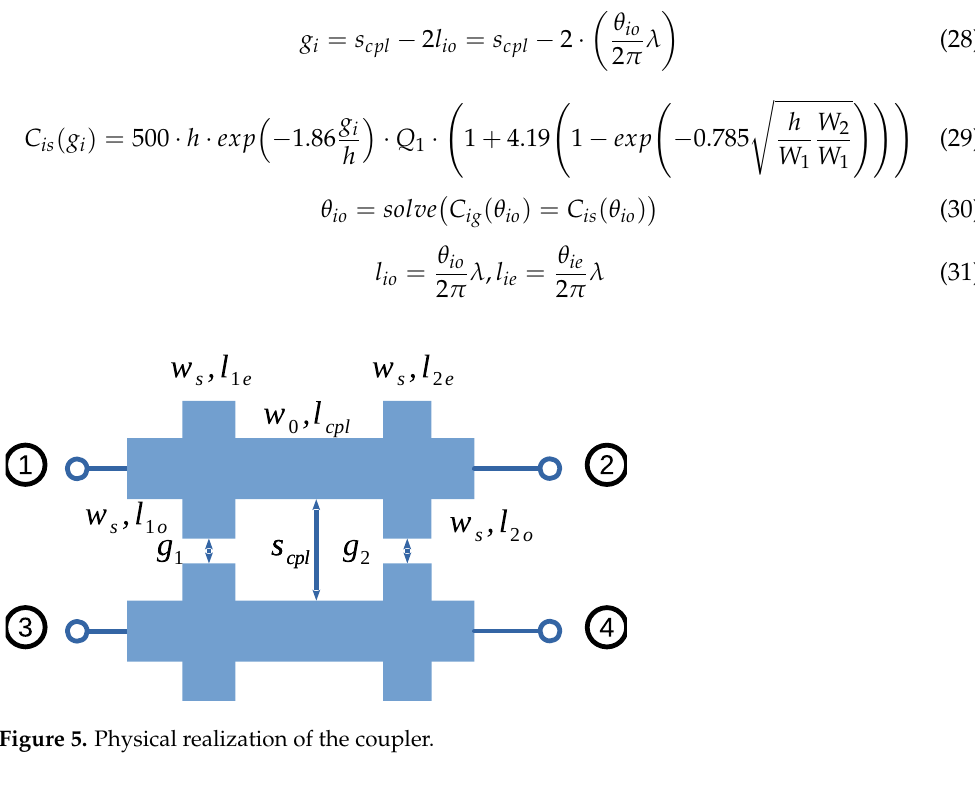
Figure 4. Distributed equivalent circuit of coupler: ( a ) Total equivalent circuit; ( b ) even-mode equivalent circuit; ( c ) odd-mode equivalent circuit.